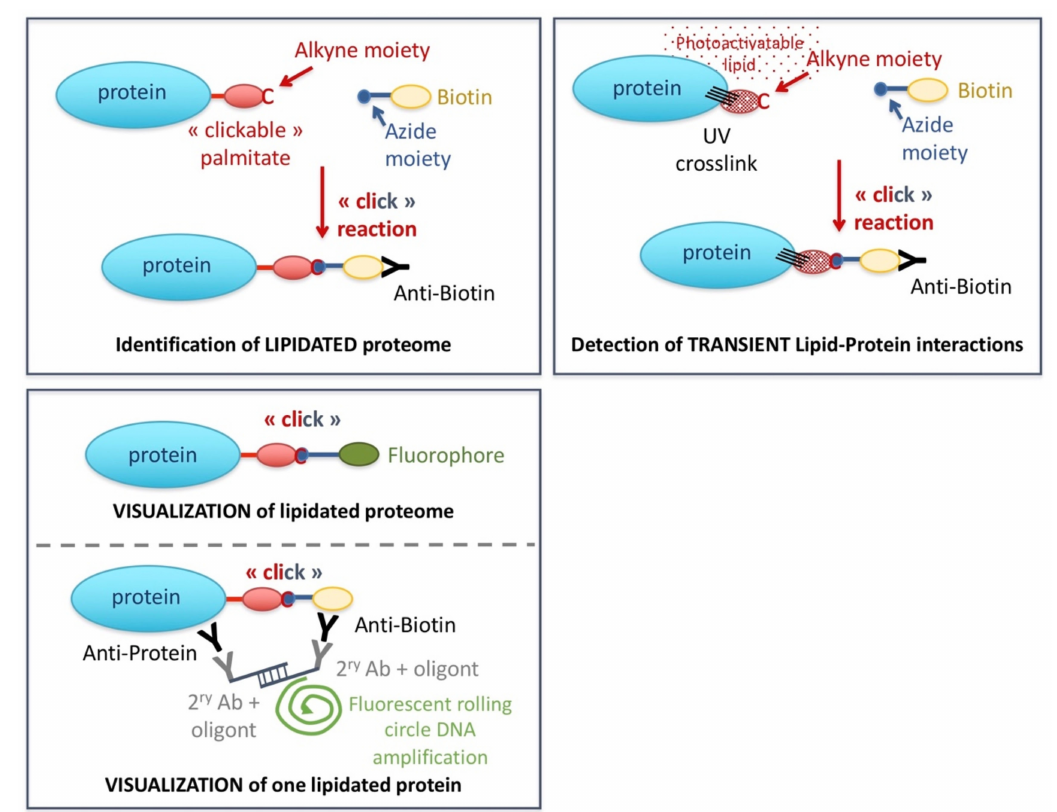
Figure 2. The use of commercially available clickable lipids allows the isolation of proteins covalently modified by lipids ( left ), interacting with lipids in a transient fashion ( right ), and also to follow the subcellular distribution of those lipids visually by fluorescence microscopy ( bottom left